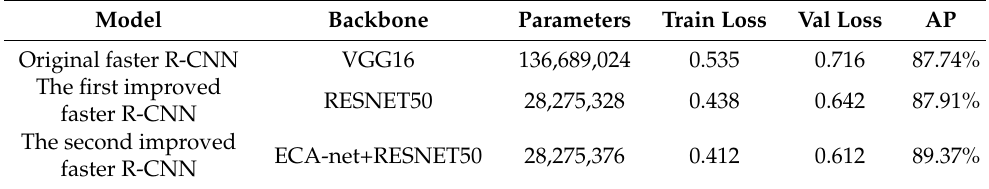
Figure 10. Precision–recall curve graph under the ECA-net+Resnet50 backbone network. Table 2. Comparison of the original faster R-CNN and the improved faster